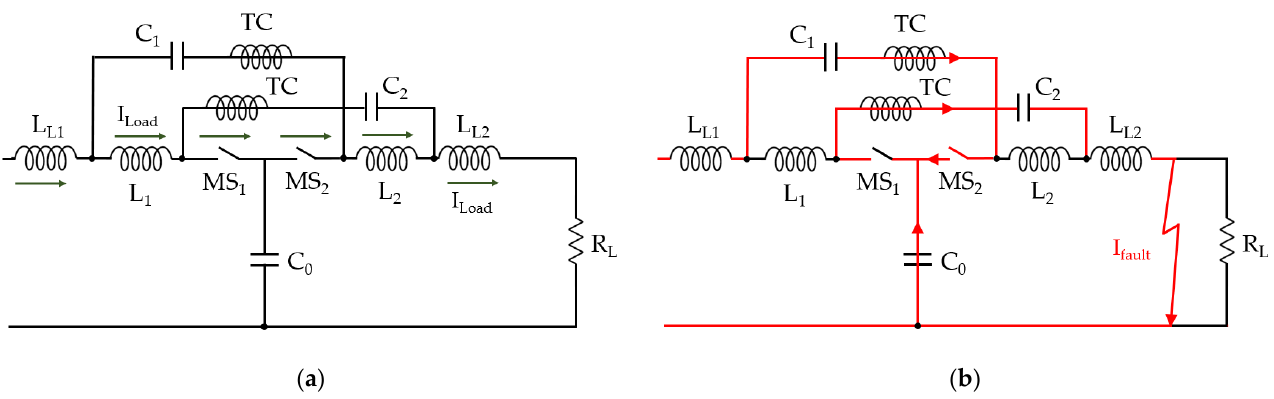
Figure 5. Schematic of the proposed Z-source circuit breaker with mechanical switch: ( a ) normal conduction; ( b ) fault conduction.